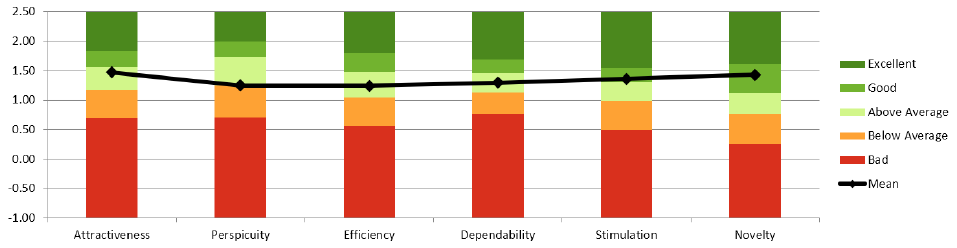
Figure 17. UEQ benchmark